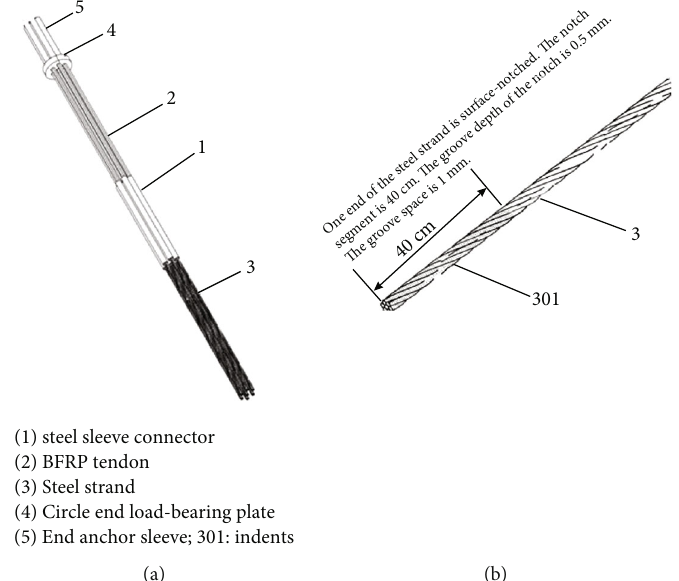
Figure 4: The developed large-tonnage pressure-type BFRP cable anchor: (a) the illustration of this developed BFRP cable anchor and (b) the end structure of the steel strand inside the steel sleeve connector.